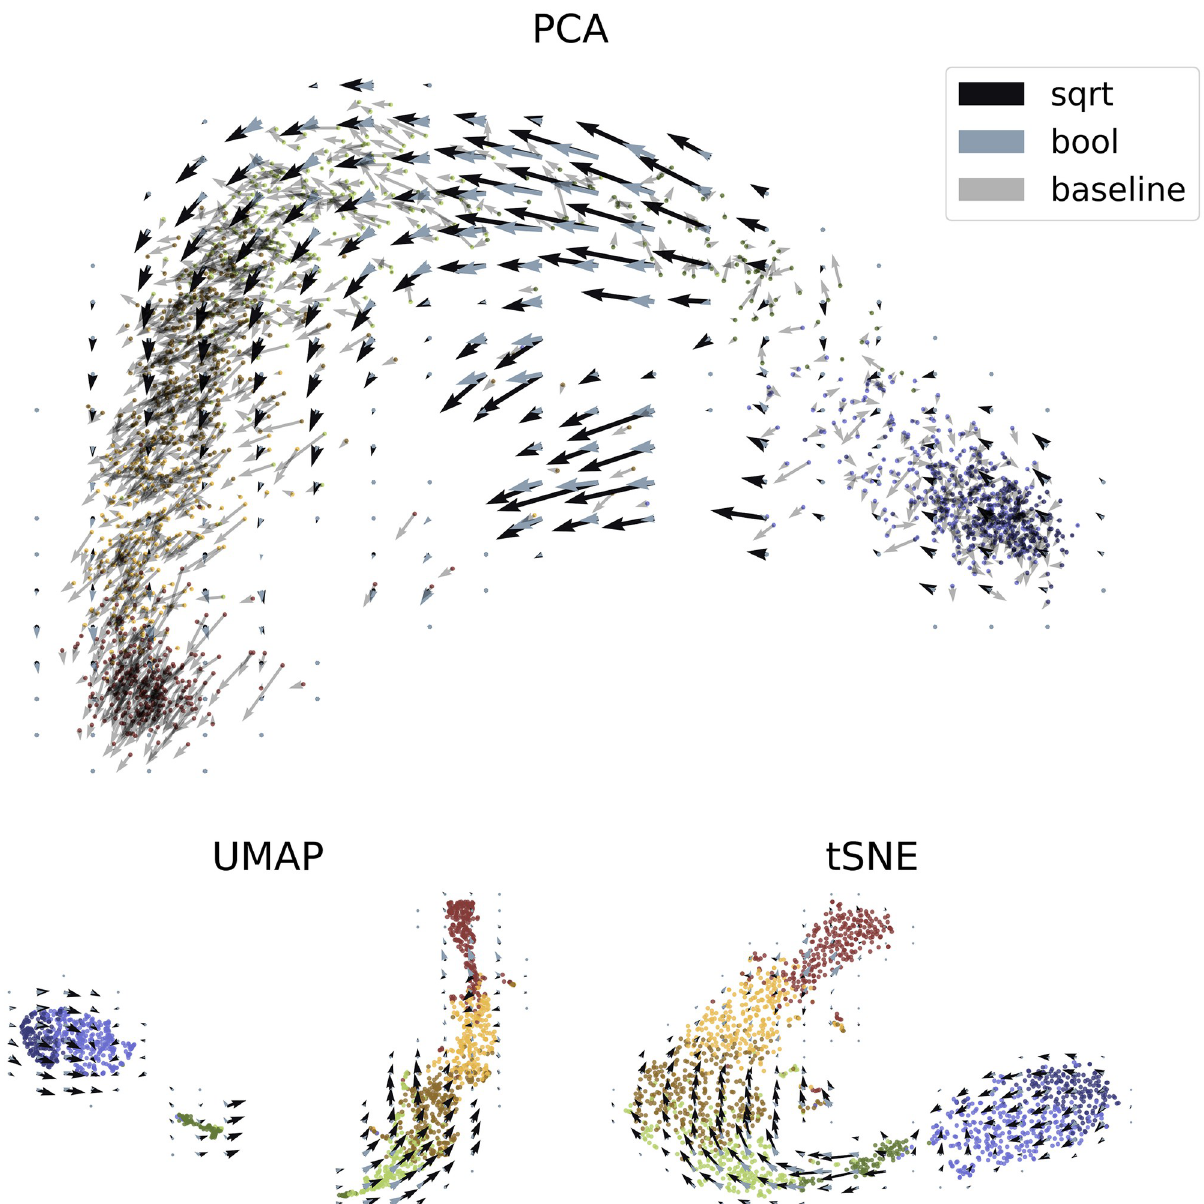
Fig 7. Performance of cell and velocity embeddings on the forebrain data. Top: PCA embedding with linear baseline and nonlinear aggregated velocity directions. Bottom: UMAP and t -SNE embeddings with nonlinear velocity projections. The palette used is derived from dutchmasters by